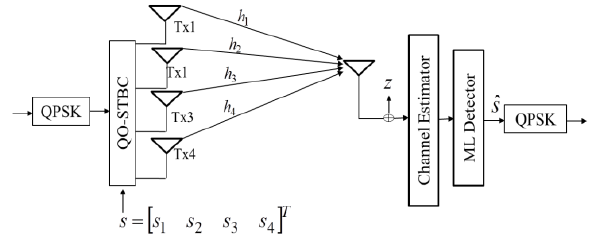
Figure 3: Architecture for Implementing QOSTBC To enable QOSTBC, EVCM is constructed as (27) for 4×1 transmission; for 3×1 design, h is set to zero. Noise terms 4 (AWGN) are generated and added to each receiver branch respective to the transmitting branch. In the receiver, the linear decoding shown in (28) is performed to estimate the transmitted